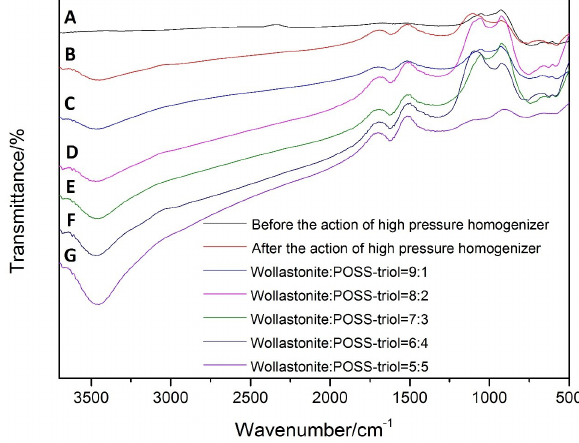
Figure 10: FTIR spectra of POSS-triol/ wollastonite composite parti- cles with different POSS-triol content (A) Before the action of high pressure homogenizer;(B) After the action of high pressure homoge- nizer;(C) Wollastonite:POSS-triol= 9:1; (D) Wollastonite:POSS-triol= 8:2; (E) Wollastonite:POSS-triol= 7:3; (F)